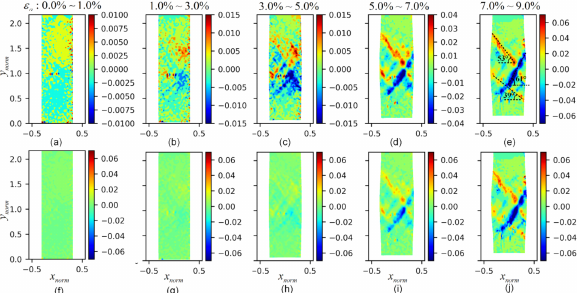
: ( a – e ) the mean fields of ( curl U ) at axial ρ ρ at axial strains of 0.0–1.0%, 1.0–3.0%, 3.0–5.0%, 5.0–7.0%, ρ